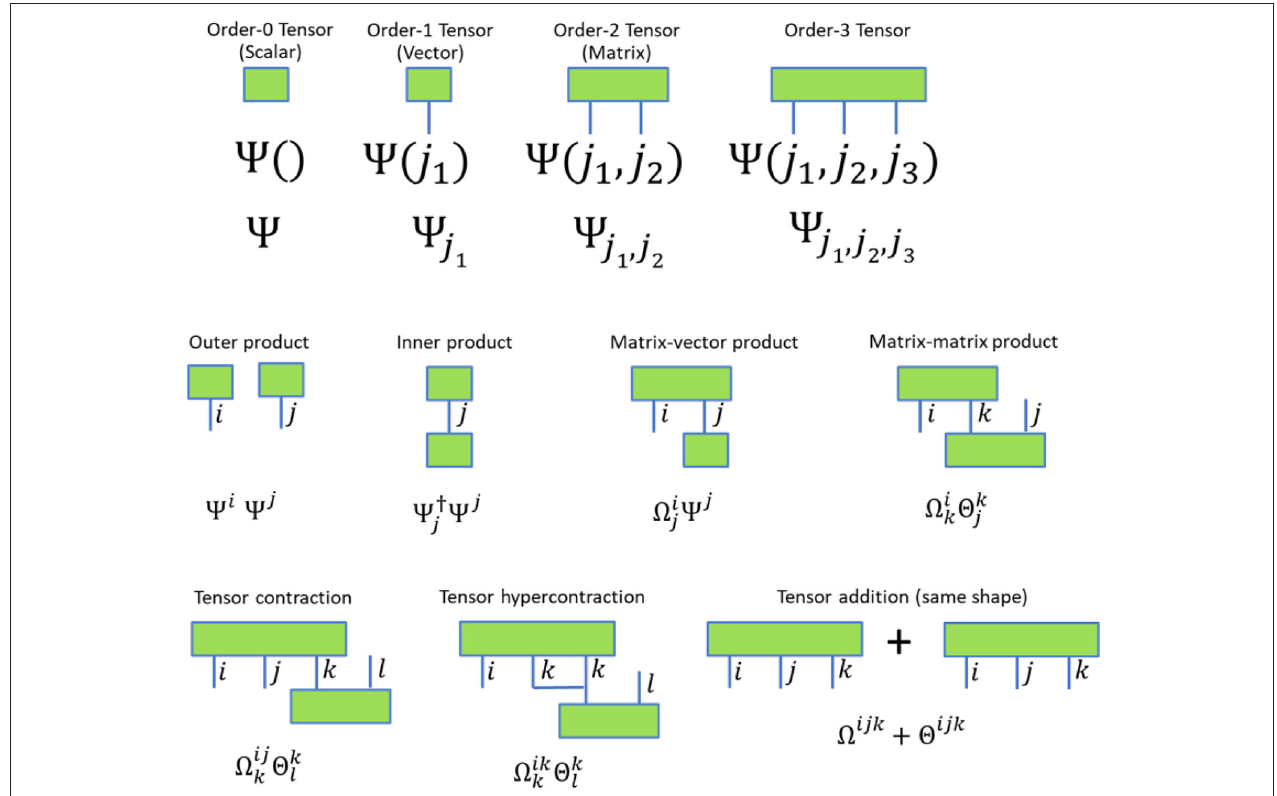
FIGURE 1 | Graphical diagrams representing tensors and tensor